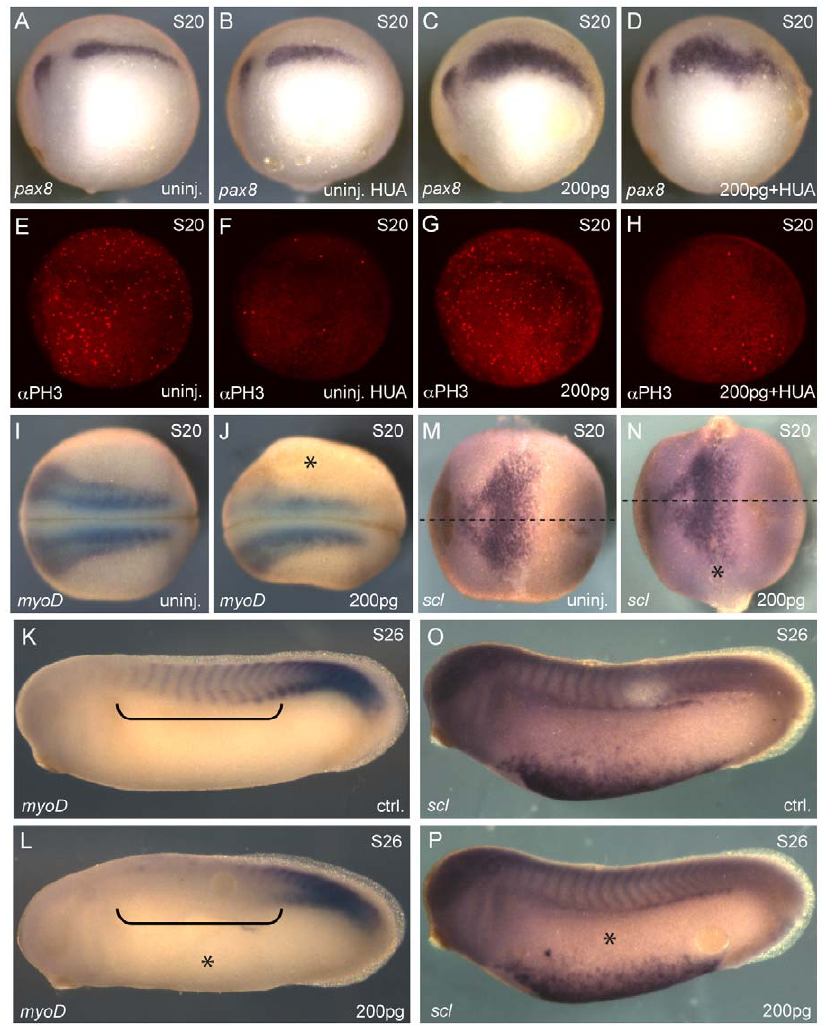
Figure 3. Ectopic lhx1 expression causes a fate transformation event. Embryos were injected (1xV2) with 200 pg of LL-VP16 mRNA at the 8- cell stage. Embryos were treated with hydroxyurea and aphidicolin (HUA) at stage 10.5/11. ( A–D ) In situ hybridization of embryos at stage 20 for pax8 . ( A ) Uninjected embryo. ( B ) Uninjected embryo treated with HUA. ( C ) Injected embryo. Expansion of pax8 expression was observed in 91% of the embryos (n=35). ( D ) Injected embryo treated with HUA. Expansion of pax8 expression was observed in 82% of the embryos (n=33). ( E–H ) Whole- mount immunostaining analysis of proliferation with anti-phospho-Histone H3 antibody, a PH3. ( E ) Uninjected embryo. ( F ) Uninjected embryo treated with HUA. ( G ) Injected embryo. ( H ) Injected embryo treated with HUA. ( I–L ) In situ hybridization of embryos for the paraxial mesoderm marker myoD . ( I, J ) Uninjected and injected embryos at stage 20. Reduced myoD expression was observed in 63% of the embryos (n=51). ( K, L ) Control and injected sides of the same embryo at stage 26. Reduced myoD expression was observed in 87% of the embryos (n=30). Anterior somites are highlighted with black brackets. ( M–P ) In situ hybridization of embryos for the lateral plate mesoderm marker scl . ( M, N ) Uninjected and injected embryos at stage 20 (n=45). Midline of the embryos is marked with a dotted line with anterior to the left. ( O, P ) Control and injected sides of the same embryo at stage 26 (n=43). The injected side of the embryos is marked with an asterisk.